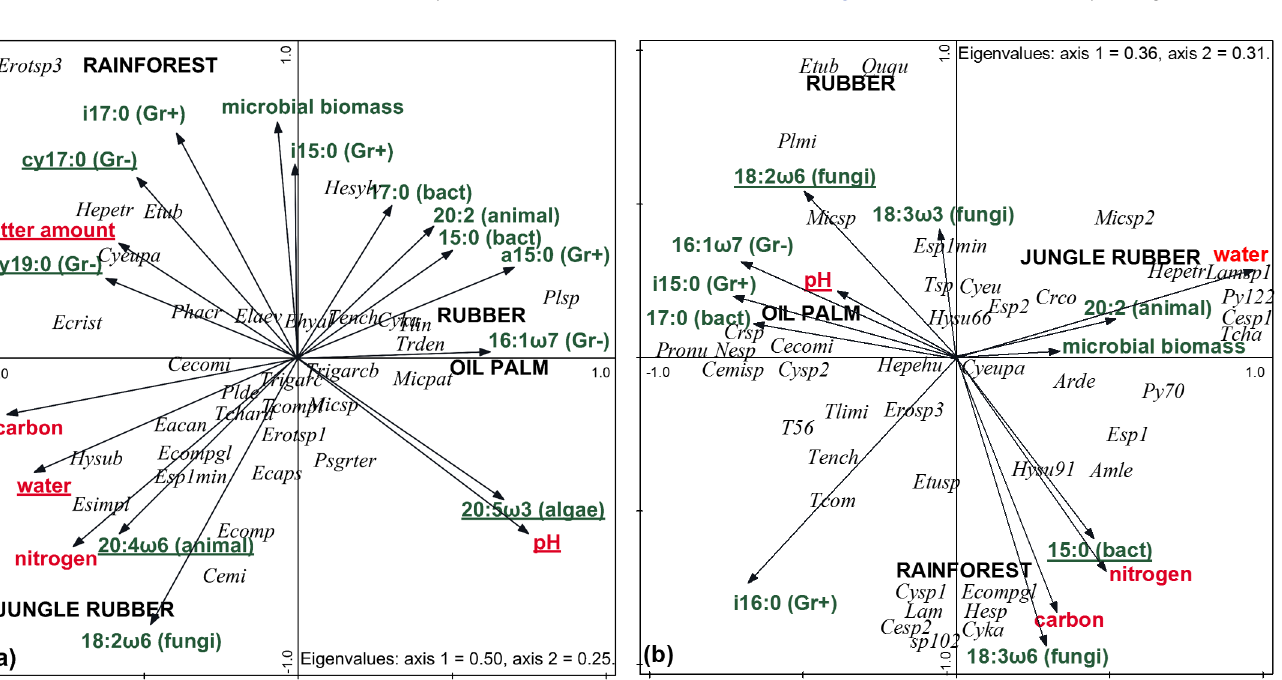
PLOS ONE | DOI:10.1371/journal.pone.0160179 July 27,